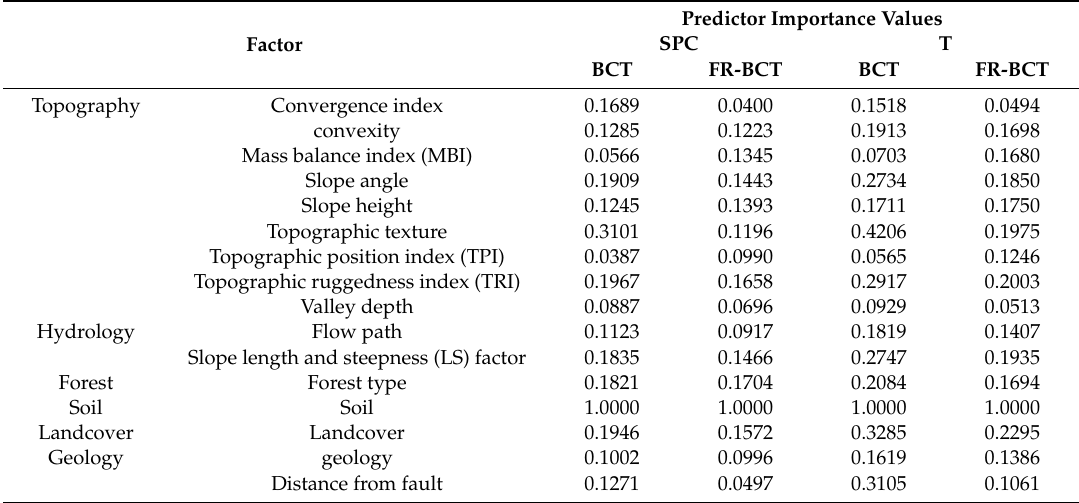
Table 2. Predictor importance values of each factor for the BCT and FR-BCT